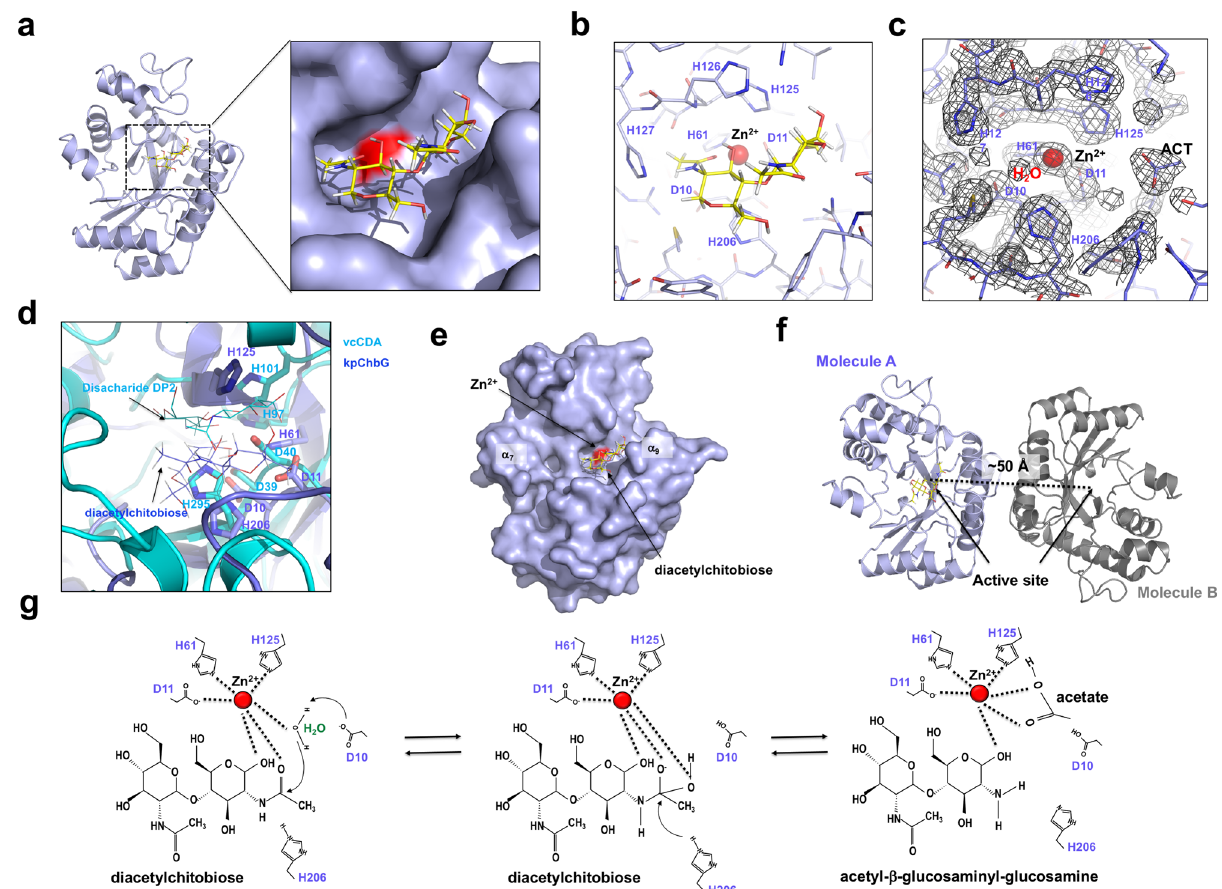
Fig. 7 Proposed model of diacetylchitobiose deacetylation mechanism by kpChbG. a Cartoon representation of diacetylchitobiose substrate docking into the putative active site of kpChbG. Magni fi ed view of docking site in the surface fi gure is provided. b Close-up of the kpChbG active site after diacetylchitobiose docking. c The electron density map around the active site of kpChbG. The 2Fo-Fc density map contoured at the 1 σ level is shown. d Structural superposition of kpChbG/diacetylchitobiose complex model (blue color) with vcCDA/disaccharide DP2 complex (Cyan color). The location of two substrates are indicated by black arrows. Five core residues at the active site were labeled. e Surface representation of diacetylchitobiose docking in the putative active site of kpChbG. The locations of α 7 helix and α 9 helix are indicated on the surface. Red-colored surface indicates Zn 2 + ion binding region. f The fi nal dimeric model of kpChbG with bound substrate in the active site. g Proposed Zn 2 + -assisted enzymatic mechanism of